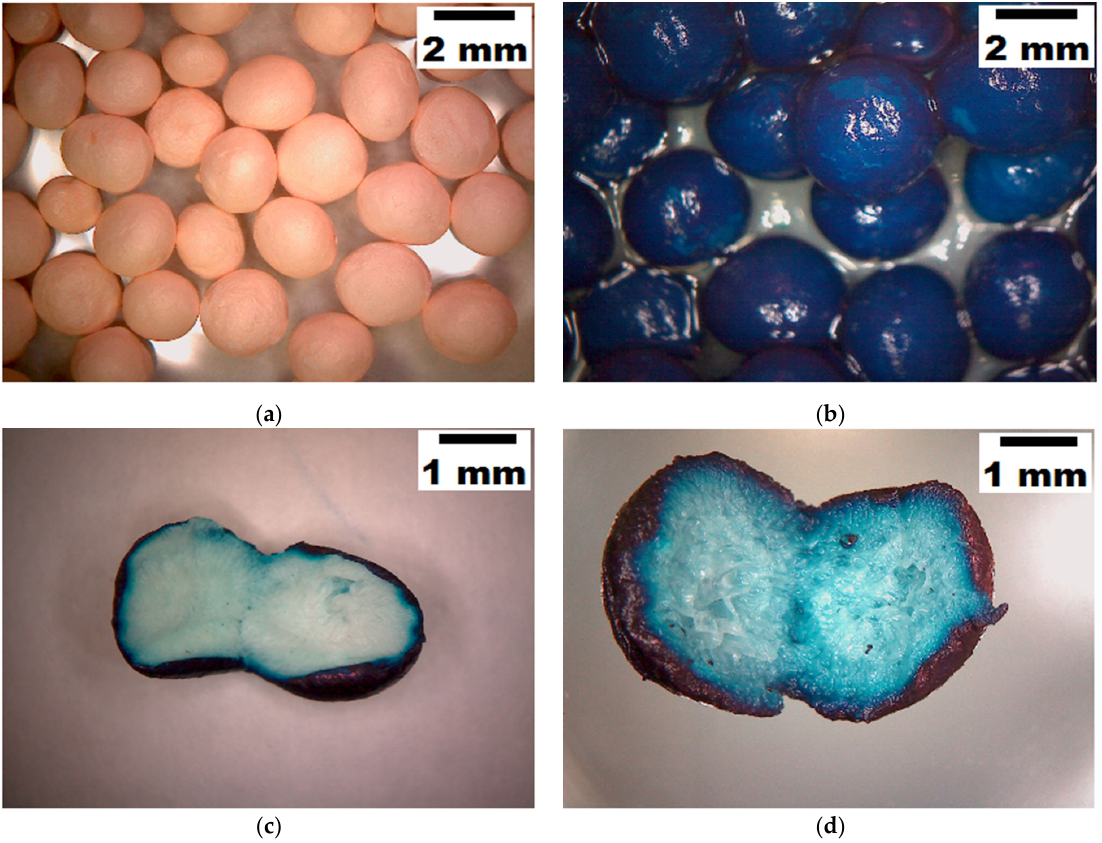
Figure 6. Morphologies of SPEEK beads: ( a ) initial state of SPEEK beads; ( b ) SPEEK beads after MB adsorption; ( c ) cross ‐ section of a SPEEK bead after MB adsorption at 300 K; and ( d ) cross ‐ section of a SPEEK bead after MB adsorption at 323 K.